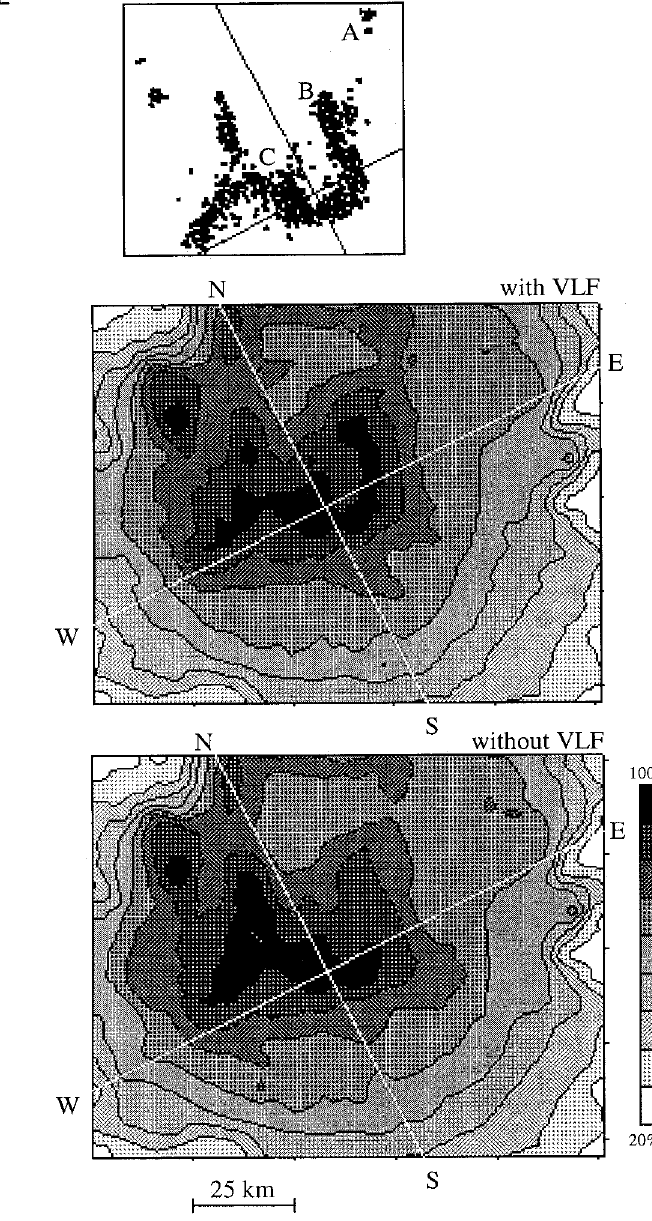
Fig. 6. The uppermost panel presents the spatial distribution of luminosity maxima. The middle panel is auroral intensity distribution for eight intervals when structured VLF chorus trains occurred. The lowest panel is also intensity distribution but for the intervals when VLF emissions were absent. The intervals of integration for middle panel were 8 following: (1) 01.34:37.6-:41.0; (2) 01.34:43.0-:45.2; (3) 01.34:49.4-;53.0; (4) 01.34:56.2-:59.0; (5) 01.35:06.0-:11.0; (6) 01.35:15.5-:20.0; (7) 01.35:21.4-:25.0; (8) 01.35:26.5-:28.5. For the bottom panel the integration was made in between those just